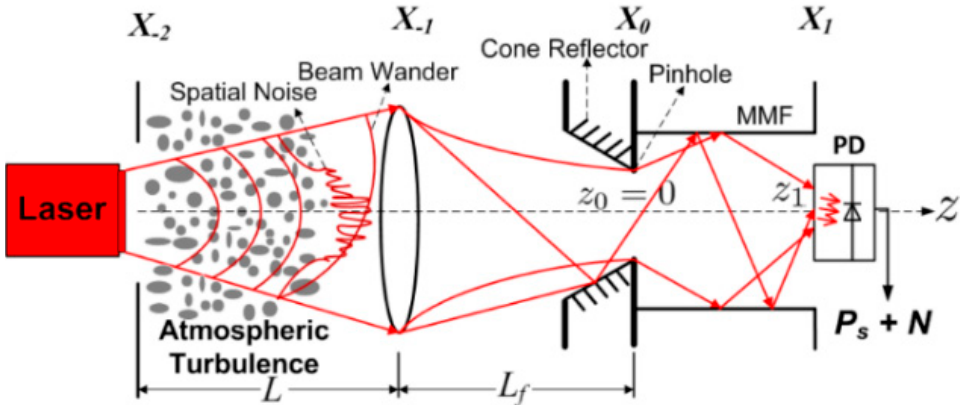
Figure 11. The OSF composed of a cone reflector, pinhole, and MMF as the optical filter to improve the FD method.